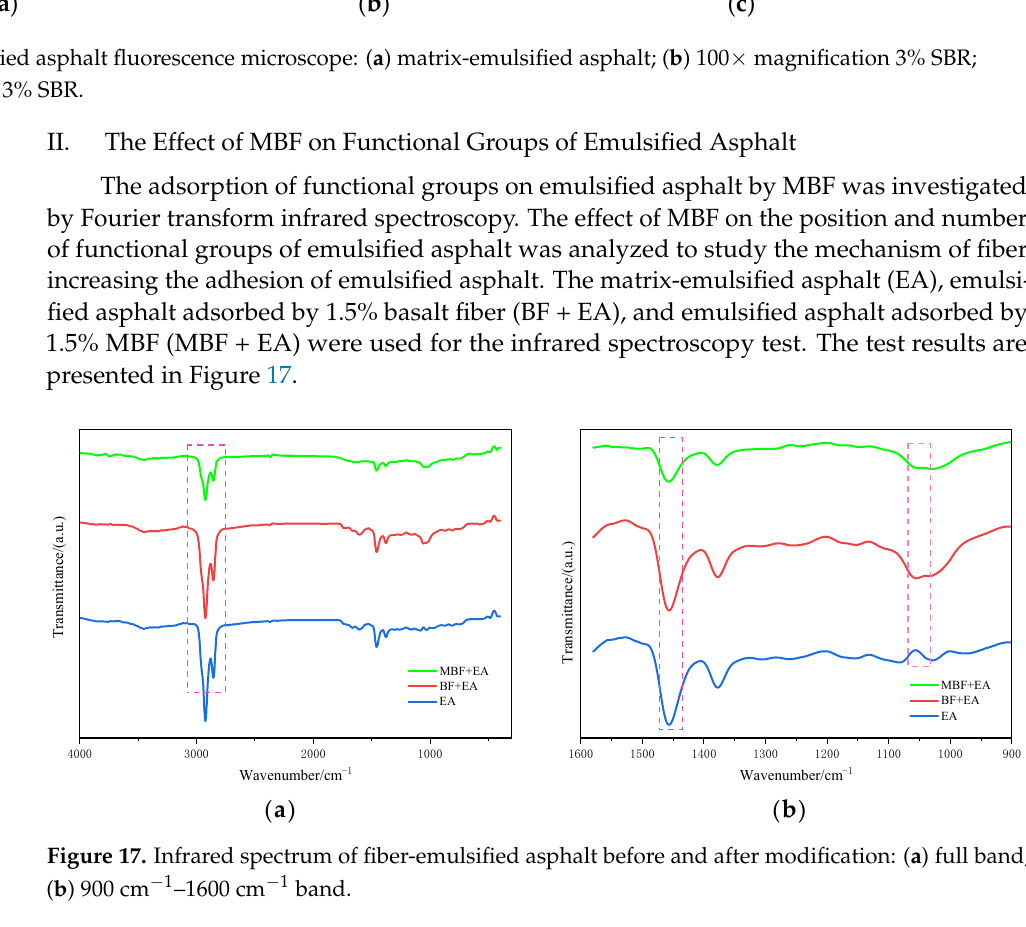
Figure 16. SBR-emulsified asphalt fluorescence microscope: ( a ) matrix-emulsified asphalt; ( b ) 100× magnification 3% SBR; ( c ) 400× magnification 3% SBR.